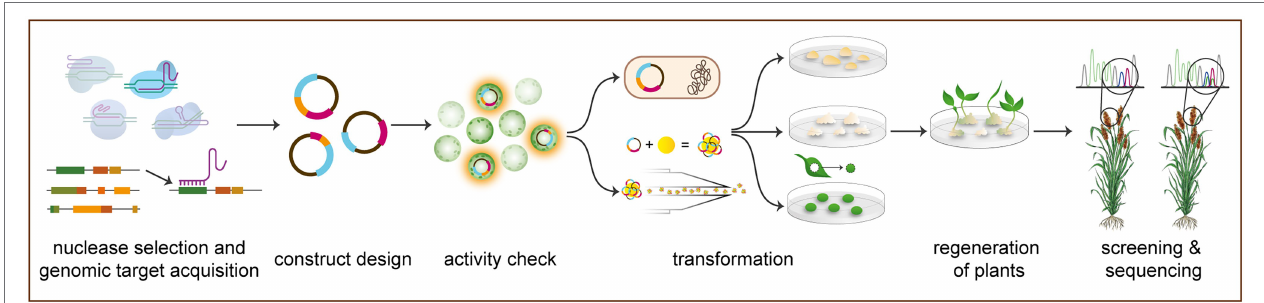
FIGURE 2 | Generalized workflow of CRISPR/Cas-mediated gene editing in orphan crops. The process begins with genomic target acquisition and nuclease selection in which a genomic target is selected based on basic research and a desired gene edited phenotype (see Supplementary Table 1 ). Gene editing approaches may be based on prime editing, base editing, knock-in, or gene knockout, which are mediated by a variety of nucleases (see “Current Methodology of Gene Editing in Orphan Crops”). Guide RNAs (gRNAs) are subsequently designed for targeting Cas nucleases to site of interest. Next, gRNAs and Cas are cloned under relevant promoters for expression in planta , in preparation for bacterial transformation. Gene editing construct activity can be confirmed transiently, usually in protoplasts. Next, the construct is transformed stably into plant material to be regenerated. Transformed plants are subsequently regenerated from callus and selected via antibiotic or herbicide resistance. These regenerated primary transformants are then screened and sequenced to determine successful target gene editing. All transgenic DNA can finally be segregated out through breeding to achieve transgene-free gene edited plants (not